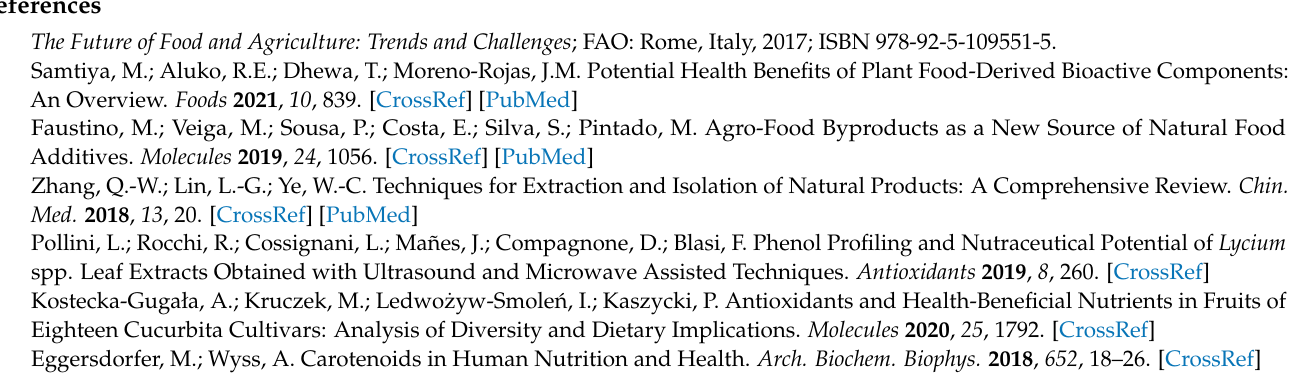
Figure S3: Fragment ion spectrum for α -carotene isolated by